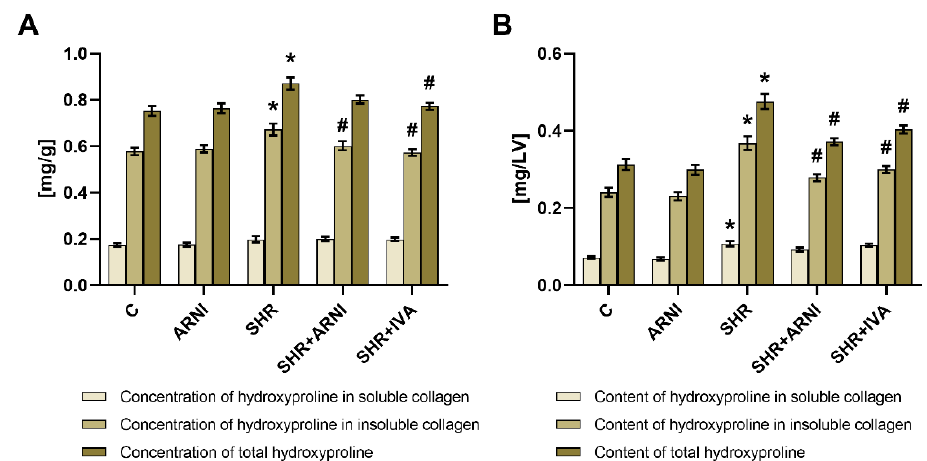
Figure 2. Effect of ARNI and ivabradine on hydroxyproline concentration in soluble and insoluble collagenous proteins and on the total hydroxyproline concentration ( A ), and on hydroxyproline content in the soluble and insoluble collagenous proteins, and on the total hydroxyproline content ( B ) in the left ventricle in SHRs after six weeks of treatment. ARNI, sacubitril/valsartan; C, Wistar controls; IVA, ivabradine; SHRs, spontaneously hypertensive rats. Results are presented as means ± SEM. n = 15 per group. One-way, two-tailed ANOVA followed by multiple comparisons with a Bonferroni post-hoc test; * p < 0.05 vs. C; # p < 0.05 vs. SHR.